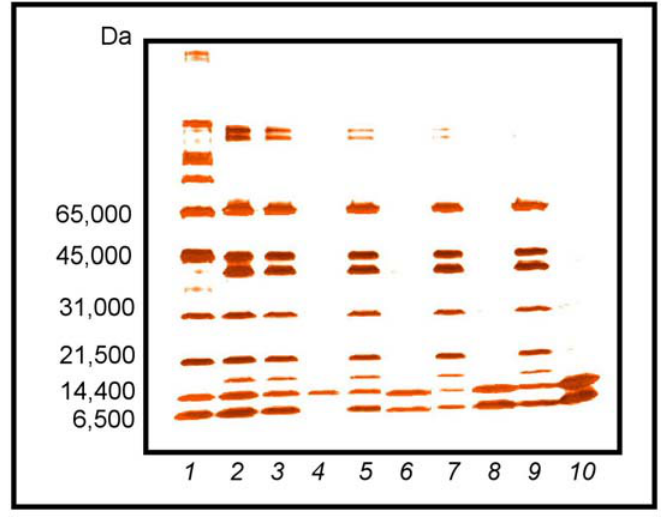
Figure 6. SDS-PAGE analysis of dye-loaded magnetic and intermediate pAm particles with varied iron oxide content incubated with MW markers: ( 1 ) MW ladder; ( 2 ) model protein solution; ( 3 ) supernatant from pAm particles; ( 4 ) bound by pAm particles; ( 5 ) supernatant from 100MHP; ( 6 ) bound by 100MHP; ( 7 ) supernatant from aminated 100MHP; ( 8 ) bound by aminated 100MHP; ( 9 ) supernatant from dye-loaded 100MHP; ( 10 ) bound by dye-loaded